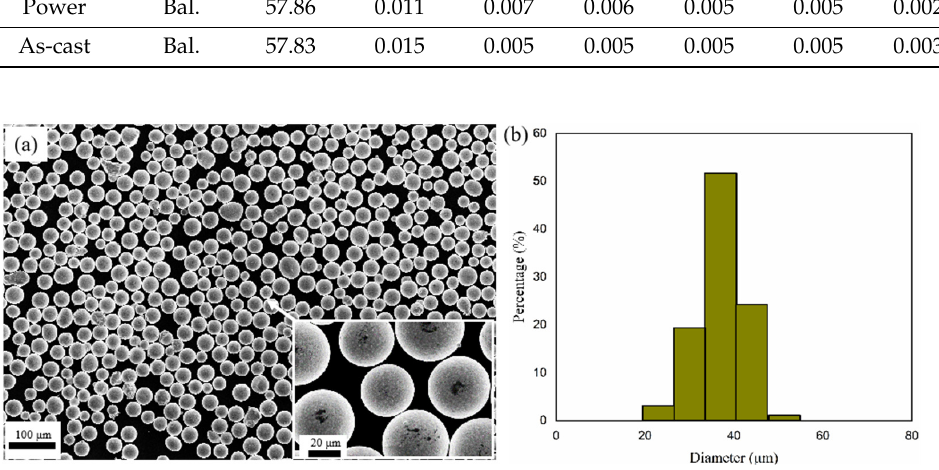
Figure 1. Sn58Bi alloy powders for LBPBF: ( a ) power morphology observed by SEM, ( b ) power diameters distribution.